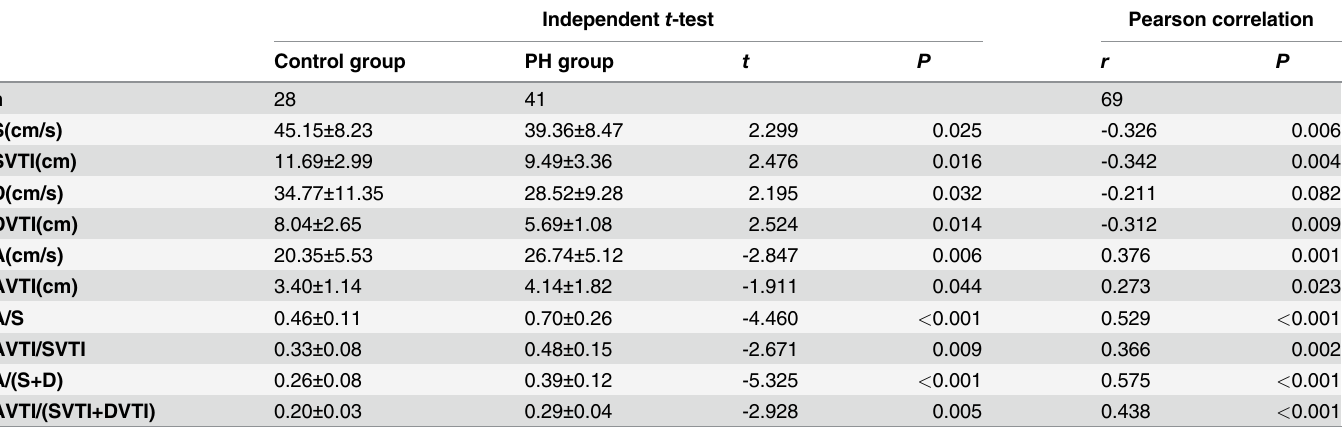
Table 2. Changes of MHV Spectral Parameters in the PH group.